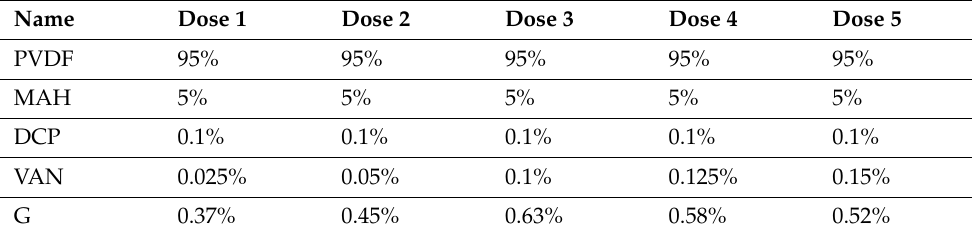
Table 5. A list of the specific compositions used in blending with different VAN